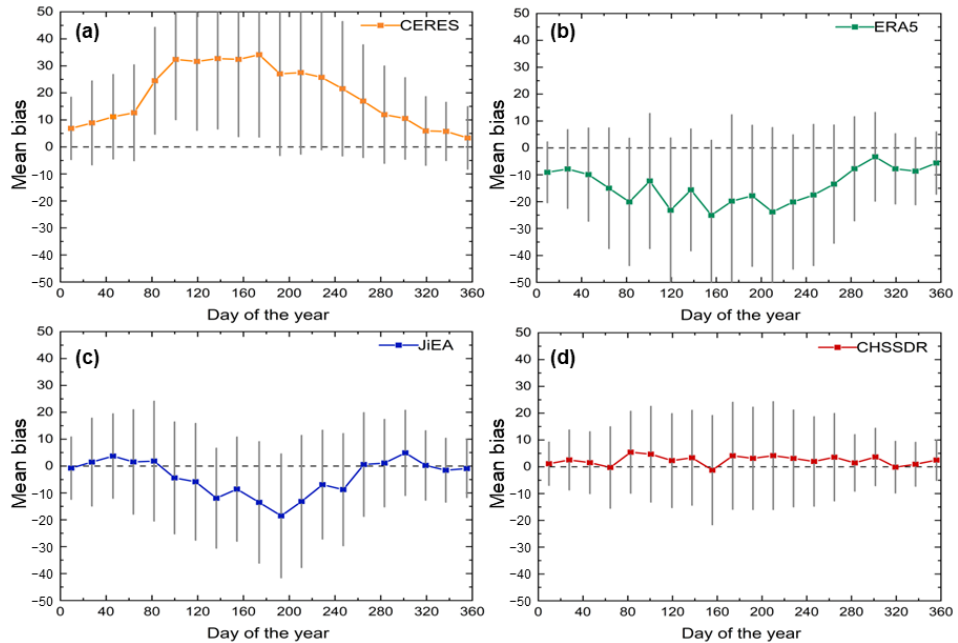
Figure 6. Comparison of mean bias for different diffuse solar radiation products: ( a ) CERES, ( b ) ERA5, ( c ) JIEA, and ( d ) CHSSDR.